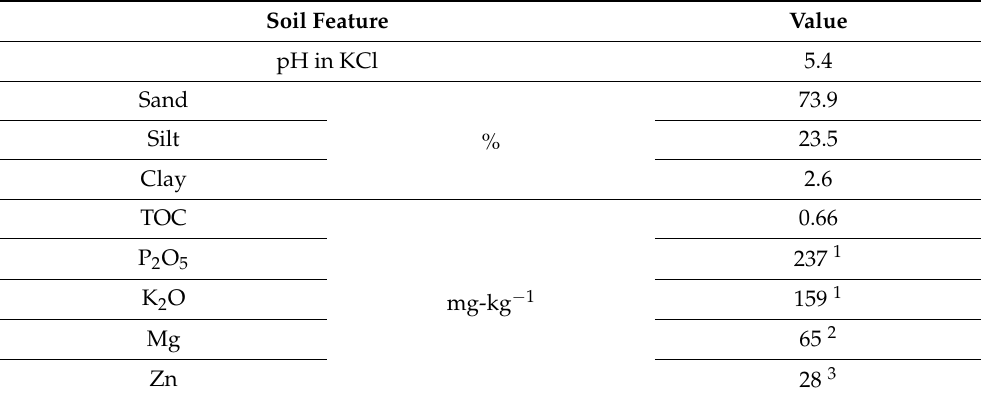
Table 1. Properties of soils used in the experiment. Soil